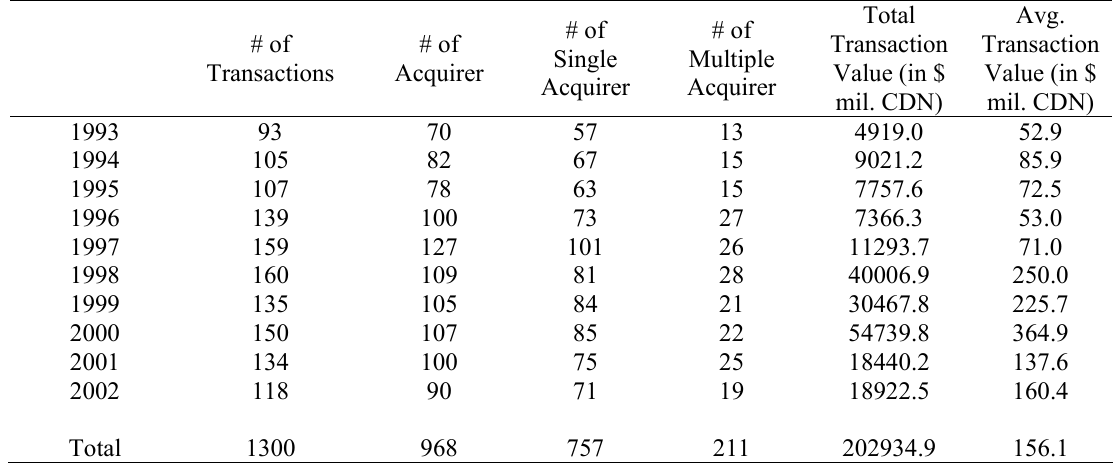
Table 1. Yearly and Sectoral Distribution of Canadian Acquirers Listed on Toronto Stock